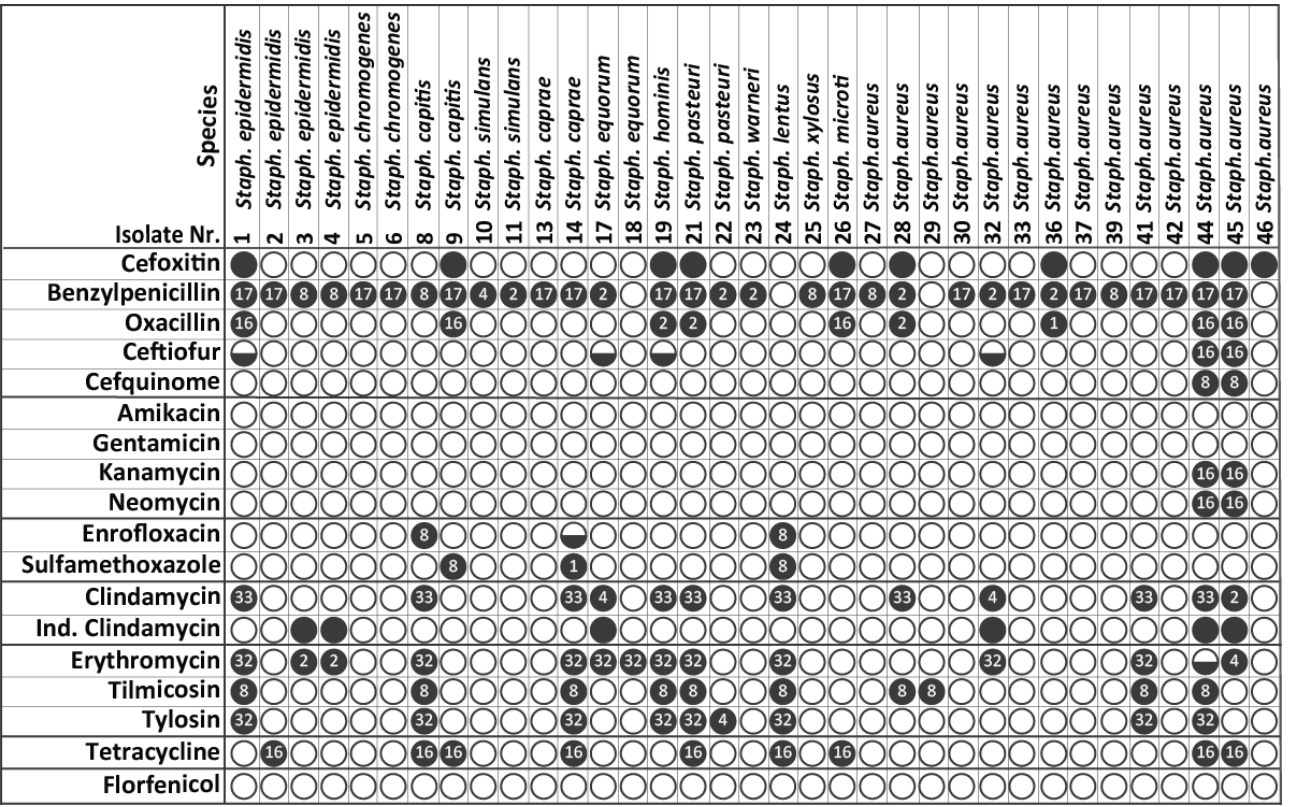
Figure 3. Determination of the antimicrobial resistance magnitude of S. aureus and CoNS strains (VITEK 2 COMPACT system); the black circle ( ● ) indicates antimicrobial resistance and the number within the black circle indicates the magnitude of resistance expressed as the ratio of the MIC of the resistant strains and the MIC of the sensitive strains of the same Staphylococcus species, whereas the empty ( о ) and the half black circles () are used for susceptible and intermediate strains, respectively.